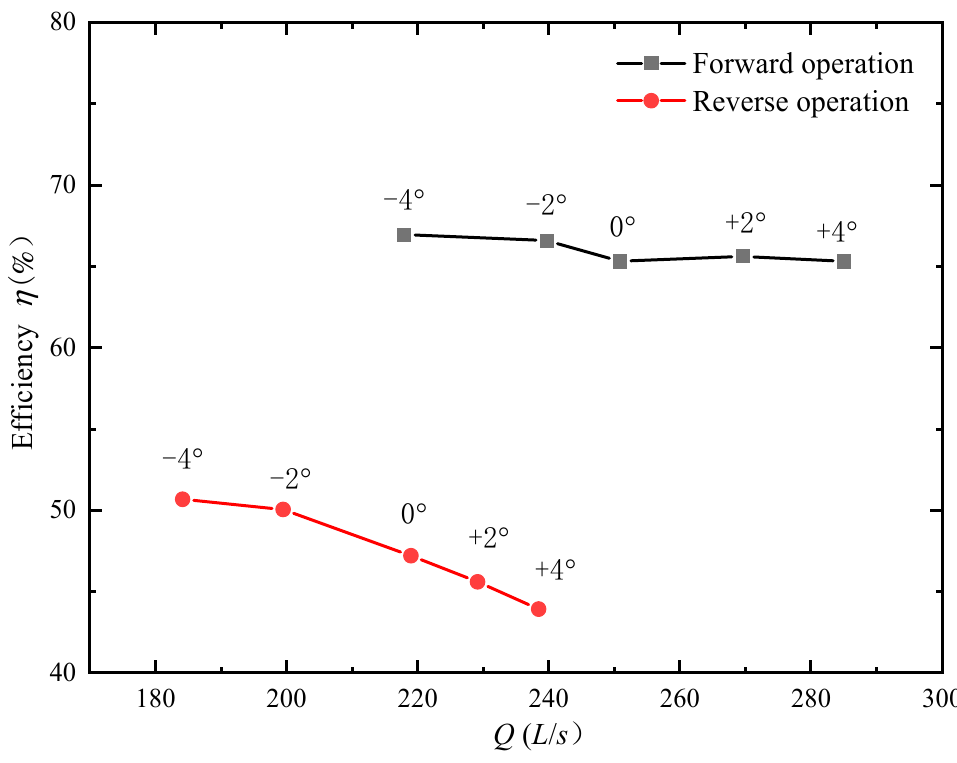
Figure 7. Optimal efficiency and corresponding flow rate at five blade angles under forward and reverse operating conditions.